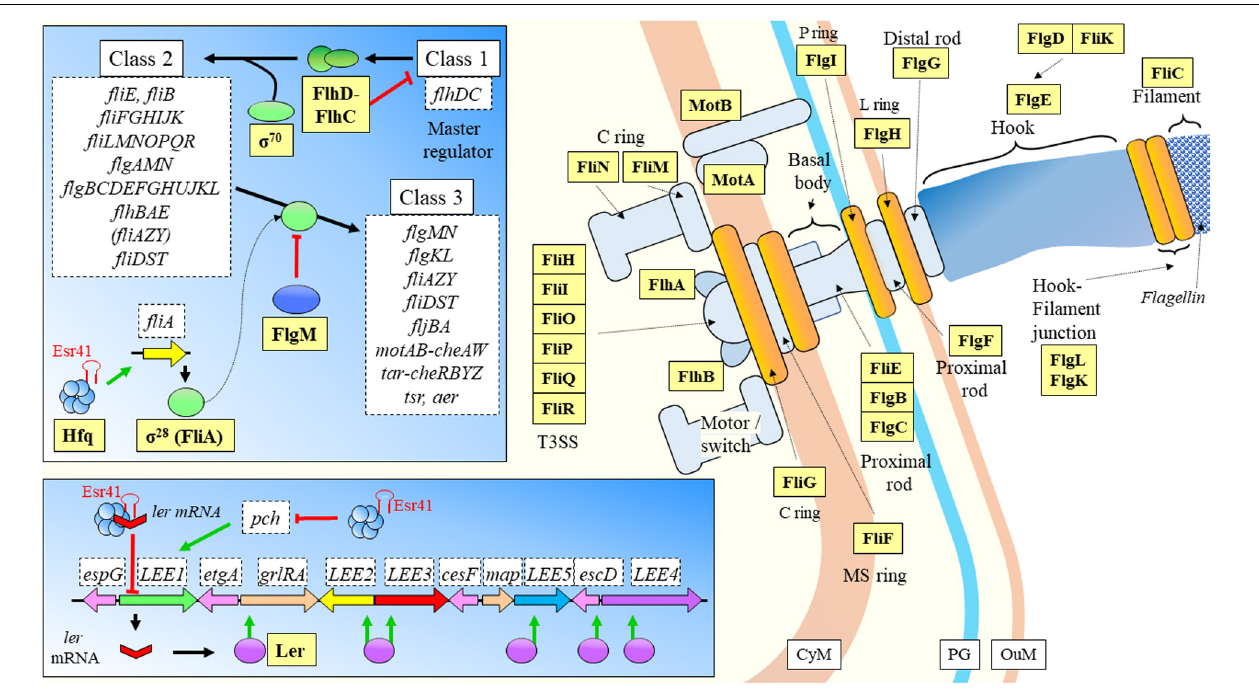
FIGURE 9 | EHEC flagellar system. The fliA encodes for a transcription factor controlling expression of class 3 genes. The sRNA Esr41 regulates positively via Hfq mediation fliA . The flagellar system is regulated by sRNAs at a key point. Esr41 has as well repressing activities over LEE1 operon, when it forms a ternary complex with Hfq and ler mRNA. This inhibition compromises coding of Ler protein, which is a transcriptional activator of different genes at the LEE. Esr41 has as well inhibitory activities over pch that facilitate LEE1 gene expression through promoter binding. CyM, Cytoplasmic membrane; HM, Host cell membrane; IL, Gastrointestinal lumen; OuM, Outer membrane; PG, peptidoglycan; T3SS, Type III secretion system. Black thick arrows indicate flow of a biological process, e.g., protein translation. Green thick arrows indicate activation. Red thick arrows with flat cap indicate inhibition. References: Kalir et al., 2001; Chevance et al., 2006;